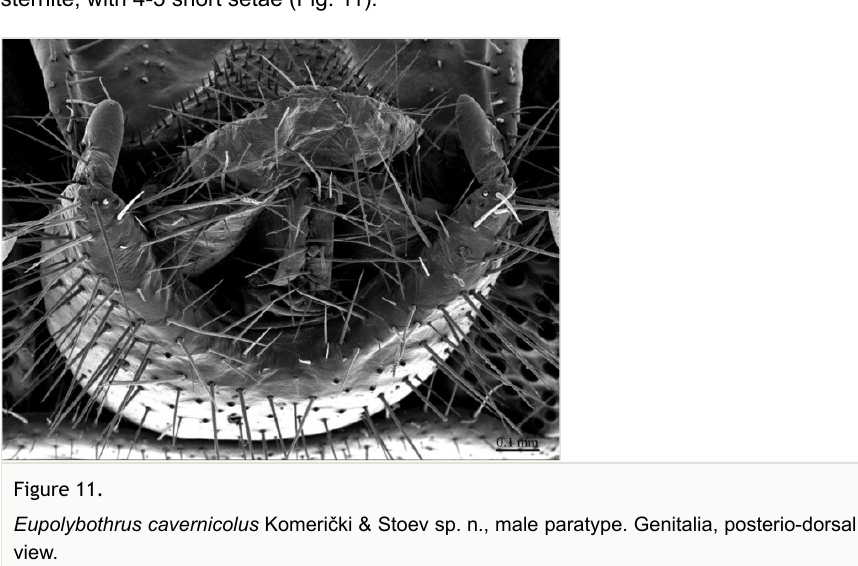
Sternites: all sternites smooth, subtrapeziform, with few sparse setae, mainly at lateral margins; posterior margins straight. Genitalia: posterior margin of male first genital sternite deeply concave, up to half of its length, posterior margin densely covered with long setae, the rest of sternite sparsely covered with shorter setae; gonopod small, hidden behind the edge of first genital sternite, with 4-5 short setae (Fig. 11).